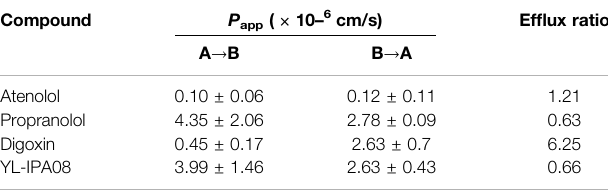
TABLE 2 | Transcellular transport of YL-IPA08 in Caco-2 cell line (n (cid:2) 3). Compound